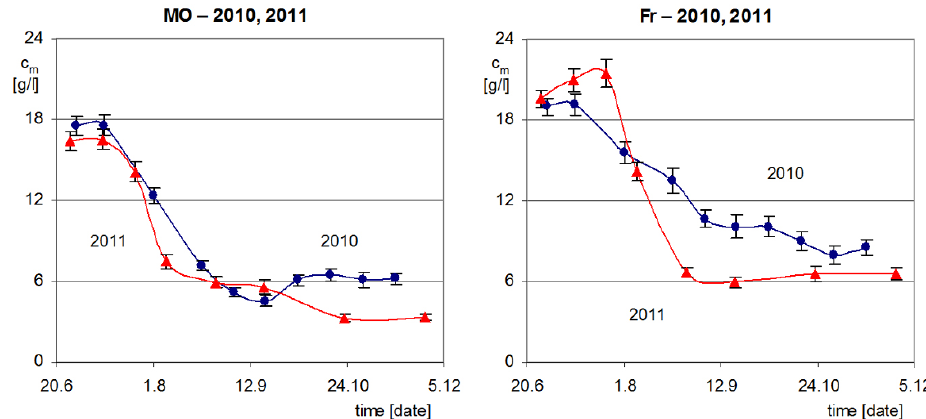
Figure 4. Changes of tartaric acid contents in Muscat Ottonel (MO) and Blue Frankish (Fr) grapes in 2010 and 2011.